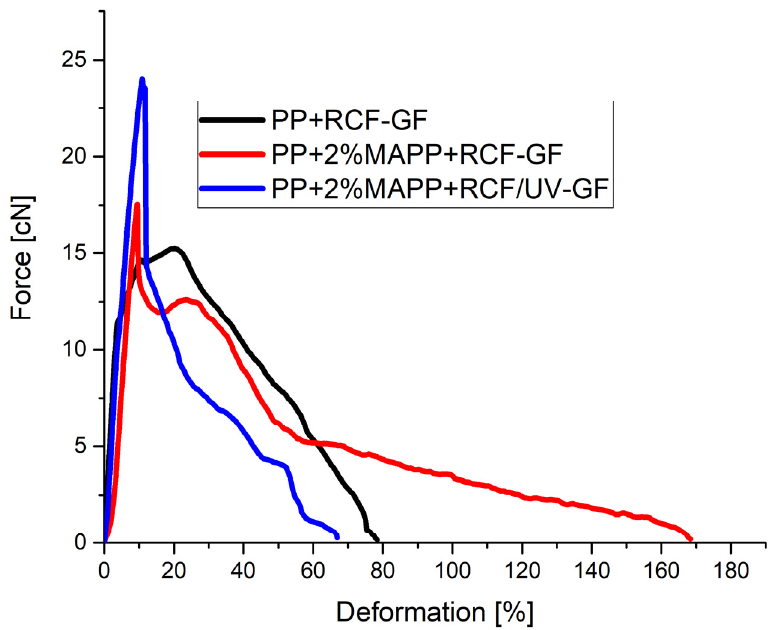
Figure 7. Force–Deformation of hybrid reinforced PP with different fiber bonding.